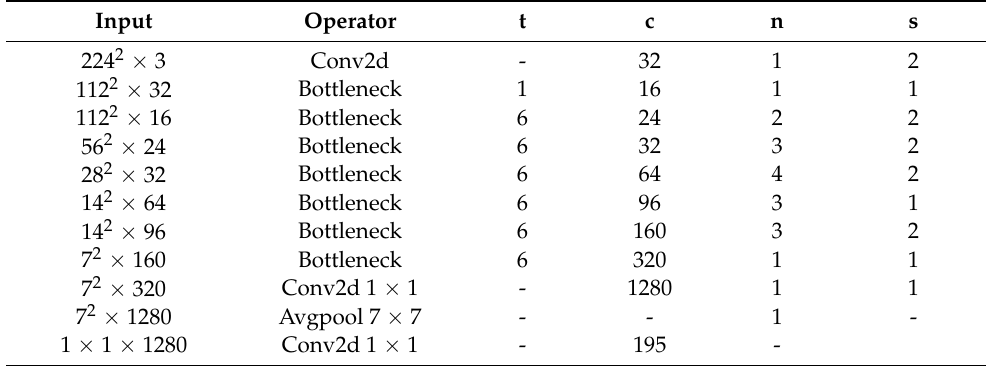
Table 1. Structure of Mobilenet